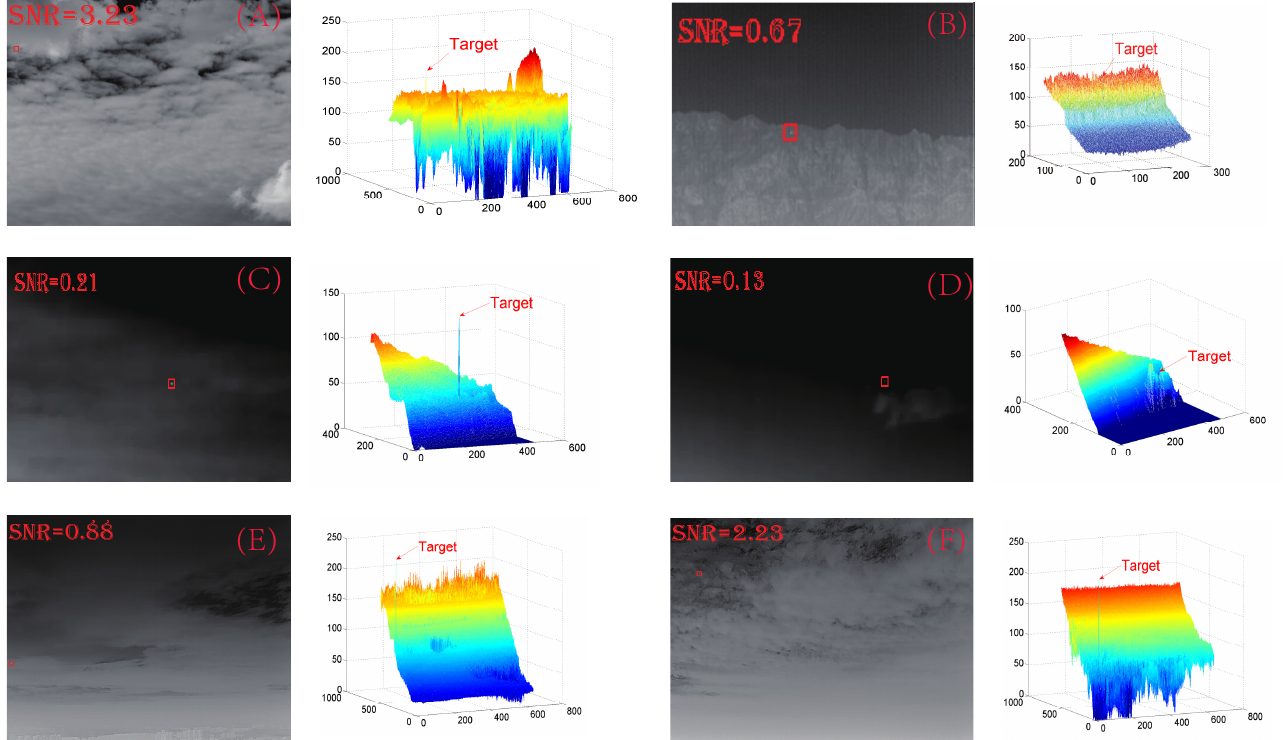
Figure 4. Sequence scene original, original